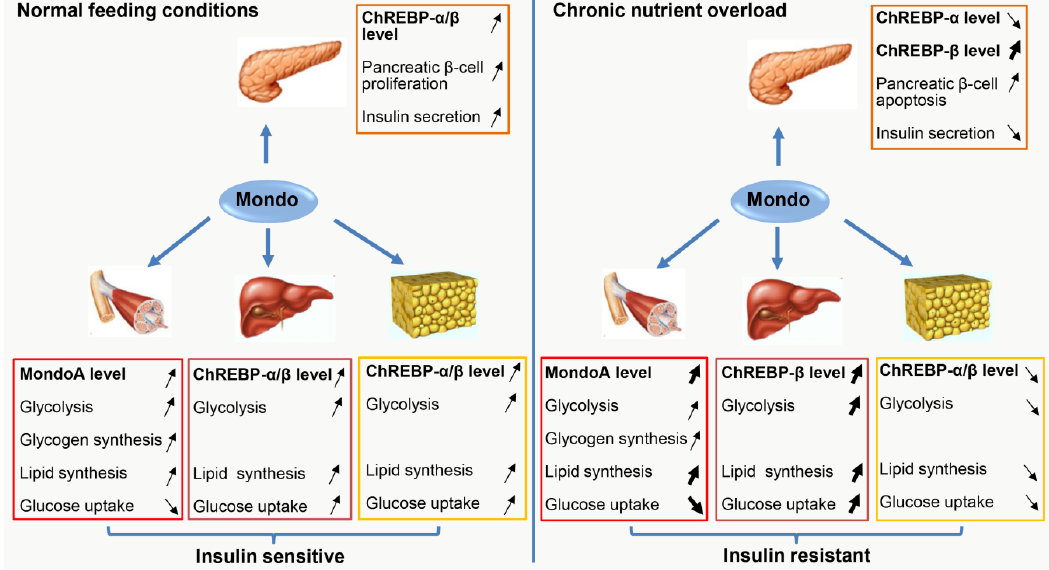
Figure 2. The roles of MondoA/ChREBP in metabolic tissues under normal feeding conditions and chronic nutrient overload. In response to normal carbohydrate diet (left panel), MondoA/ChREBP expression is induced in all metabolic tissues (including the pancreas, skeletal muscle, liver, and adipose tissue), which contributes to adaptive pancreatic β -cell proliferation and increased insulin production, and meanwhile, which also promotes glucose disposal by the muscle, liver, and adipose tissue through enhancing glycolysis, lipid synthesis, as well as glycogen synthesis. All these metabolic alterations guarantee whole-body insulin sensitivity and glucose homeostasis. However, when the body is exposed to chronic nutrient overload (right panel), the response of MondoA/ChREBP expression is not unified among the metabolic tissues. Specifically, in pancreatic β -cells, ChREBP- β expression is strongly induced, while ChREBP- α expression is downregulated, totally leading to lipo-glucotoxicity to β -cells, which causes β -cell apoptosis and reduced insulin secretion. In skeletal muscle, MondoA is persistently-activated, resulting in inhibition of glucose uptake, but promotion of lipid synthesis. Interestingly, in the liver, only ChREBP- β expression is dramatically induced, which then directly increases hepatic lipid synthesis and indirectly enhances glucose uptake. Strikingly, in adipose tissue, both ChREBP- α and ChREBP- β expression is downregulated, leading to reduced lipid synthesis and glucose uptake. Overall, the sum of this metabolic remodeling causes insulin resistance (IR). The arrow pointing up means an increase in the level or activity, the arrow pointing down means a decrease in the level or activity, and the bold arrow means the range of increase or decrease are enhanced. The cartoons used in this figure are adapted from the internet.